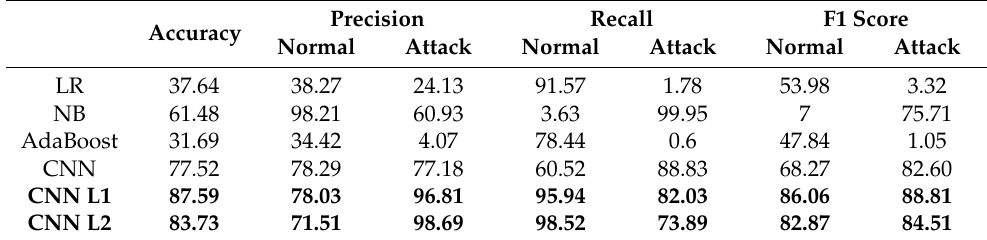
Table 10. The percentage results of Scenario